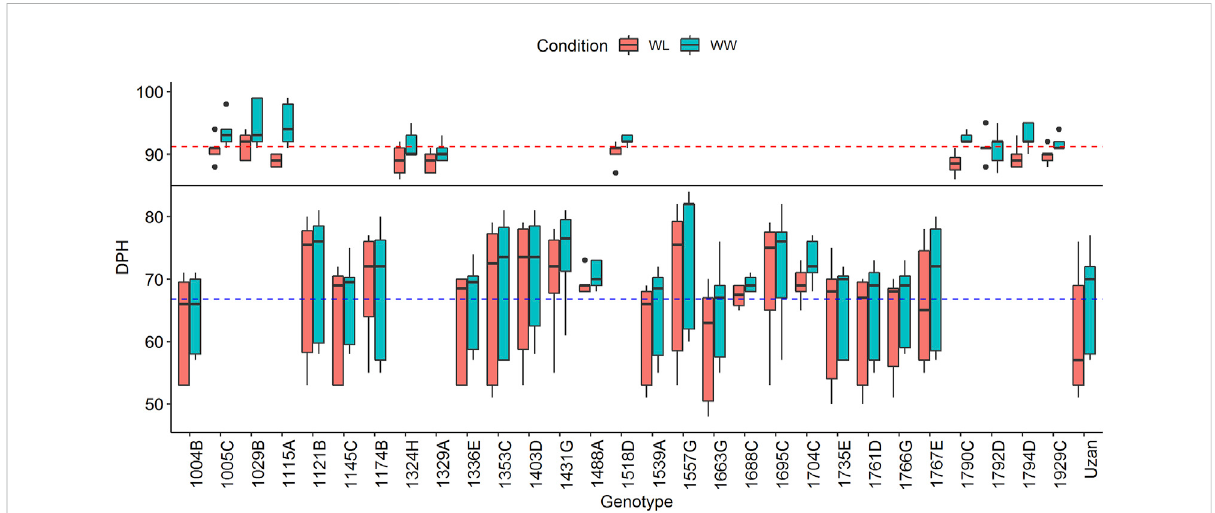
FIGURE 1 Days from planting to heading (DPH) of the complete set of 29 segmental sub-NILs in 2017. The black line indicates that plants cluster into two groups according to their DPH (for more details, see text). Blue and red dashed lines mark the mean DPH time of 66.79 and 91.22 days, respectively. Plants above the black line show delayed heading toward the elite parent Uzan and were, therefore, not considered for the phenotypic experiments in 2018 and